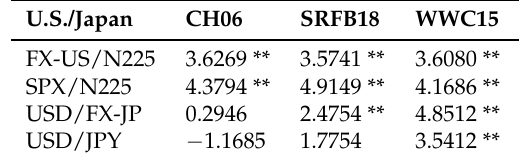
Table 7. Test statistics for stationary fractional cointegration between U.S. and Japan.